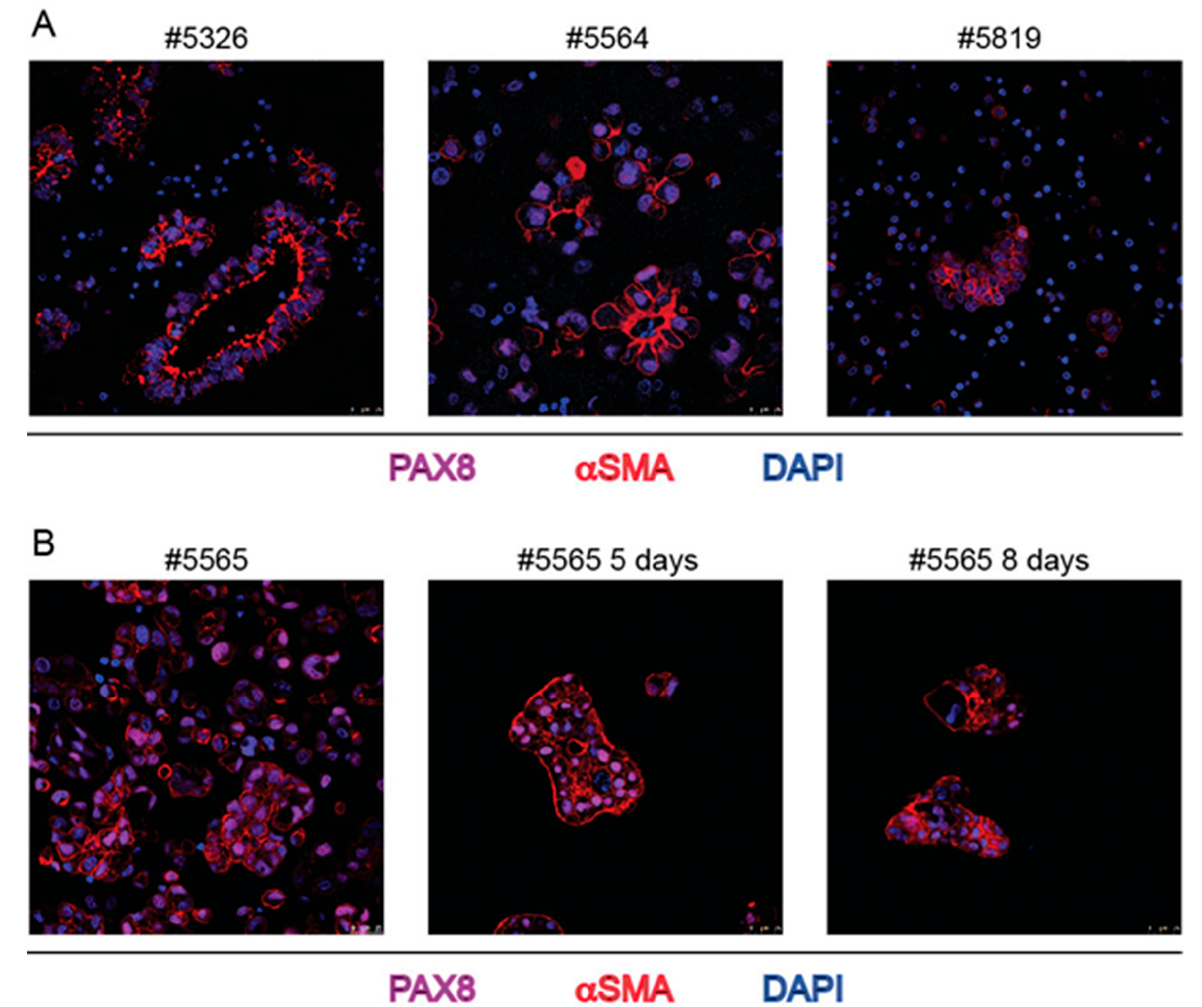
Figure 4. IF staining of spheroids from bulk ascites samples with PAX8 and α SMA MAbs and DAPI. ( A ): three independent cases; ( B ): ascites sample #5565 cultivated in Matrigel for 5 and 8 days. Numbers on top of each panel correspond to the Profiling protocol numbers of the collected ascites. Details of each #case are in Supplementary Table S1.